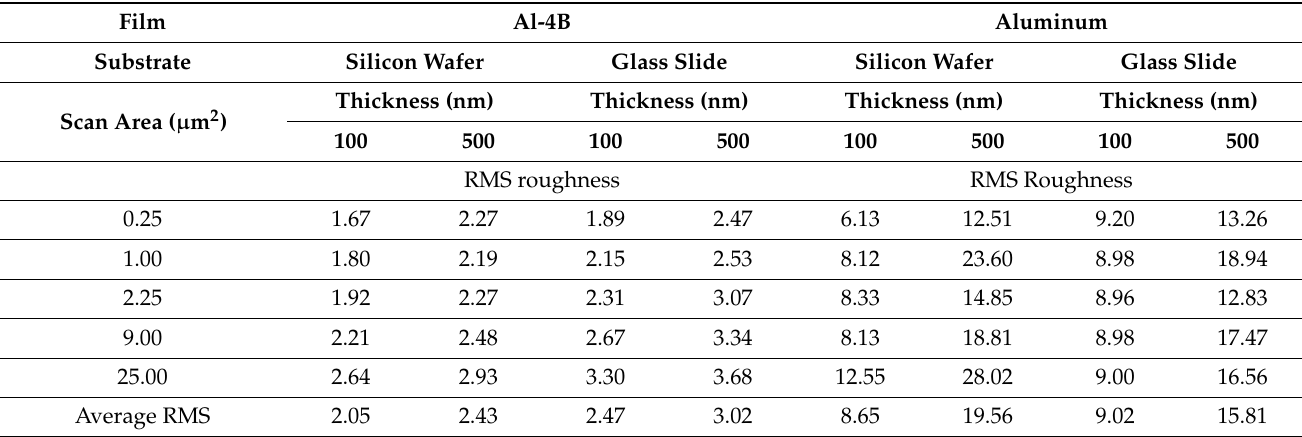
Table 2. RMS roughness for Al-4B and aluminum films deposited at 200 W onto the silicon wafer and glass slide substrates, with thicknesses of 100 and 500